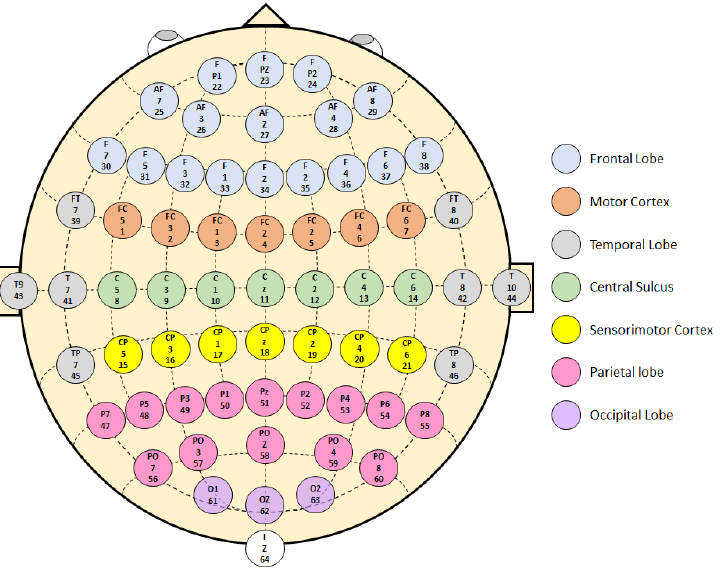
Figure 2. Brodmann areas in the 10-10 electrode positioning